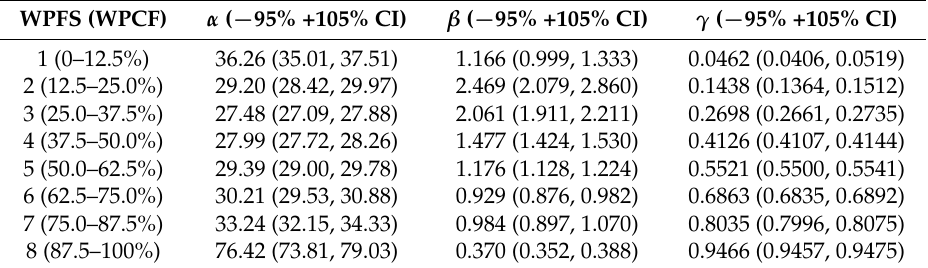
Table 1. The identified parameters of the cumulative density function (CDF) for wind forecast error w.r.t. different forecast spans *.